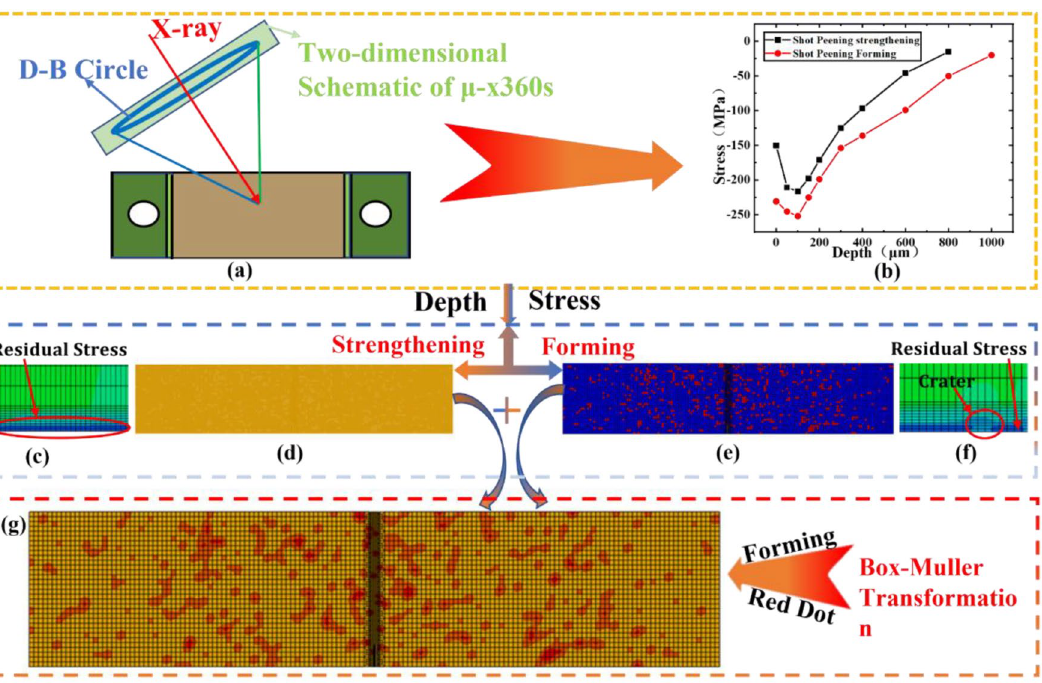
Figure 2. Residual stress distribution after S + F: ( a ) μ-360sX; ( b ) Residual stress test results; ( c ) depth direction stress; ( d ) surface layer stress; ( e ) surface layer stress; ( f ) depth direction stress; ( g ) residual stress introduction